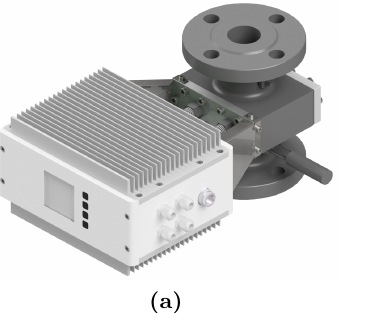
Figure 1. Industrial type of wire-mesh sensor: ( a ) 3D-CAD visualization of the sensor design; ( b ) photograph of the prototype; ( c ) sectional view.